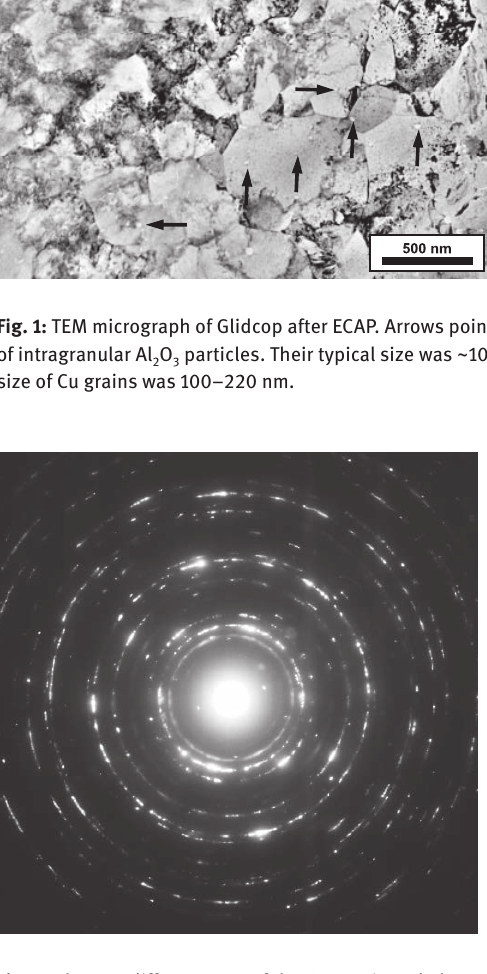
Fig. 2: Electron diffractogram of the Cu matrix and Al 2 O 3 particles from Fig. 1.